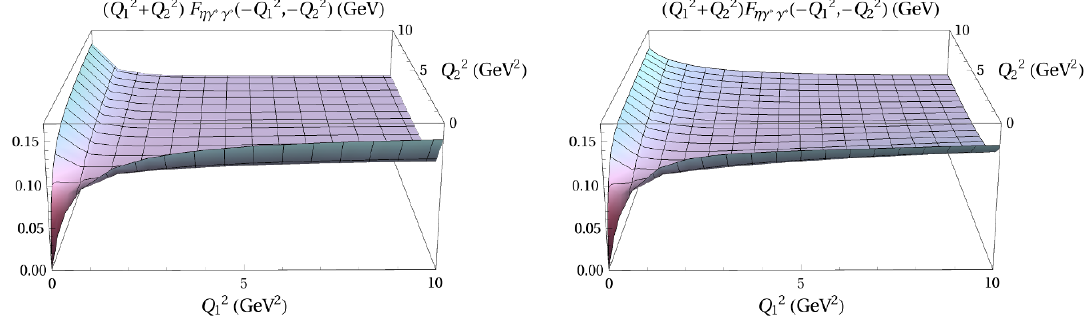
; Q 2 < 10 GeV 2 . The large- N c Regge 1 2